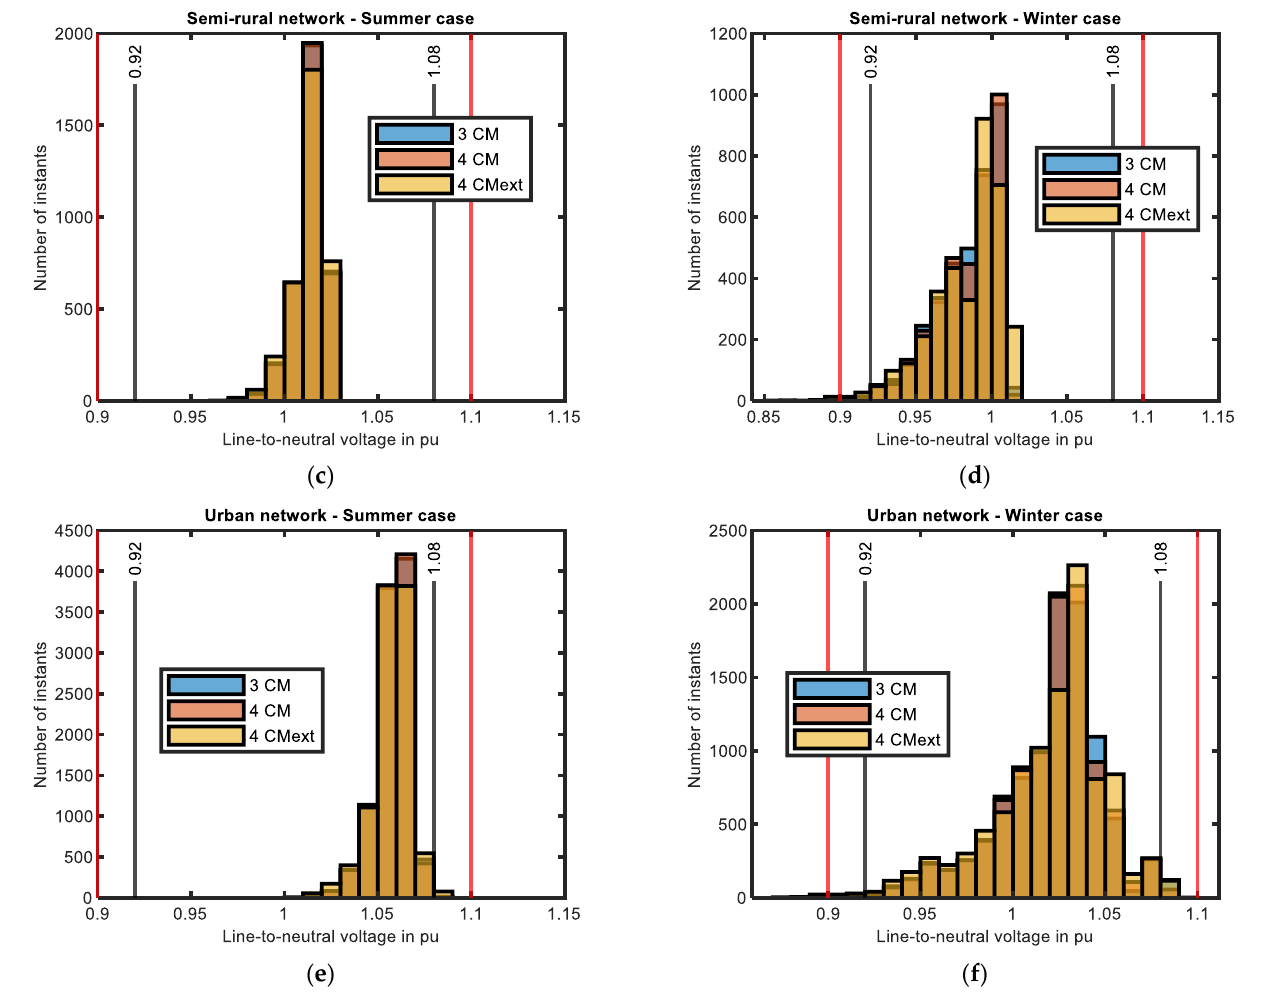
Figure 16. Occurrence on the voltage profile in the rural ( a , b ), semi-rural ( c , d ) and urban ( e , f ) network and summer ( a , c , e ), and winter ( b , d , f ) cases.